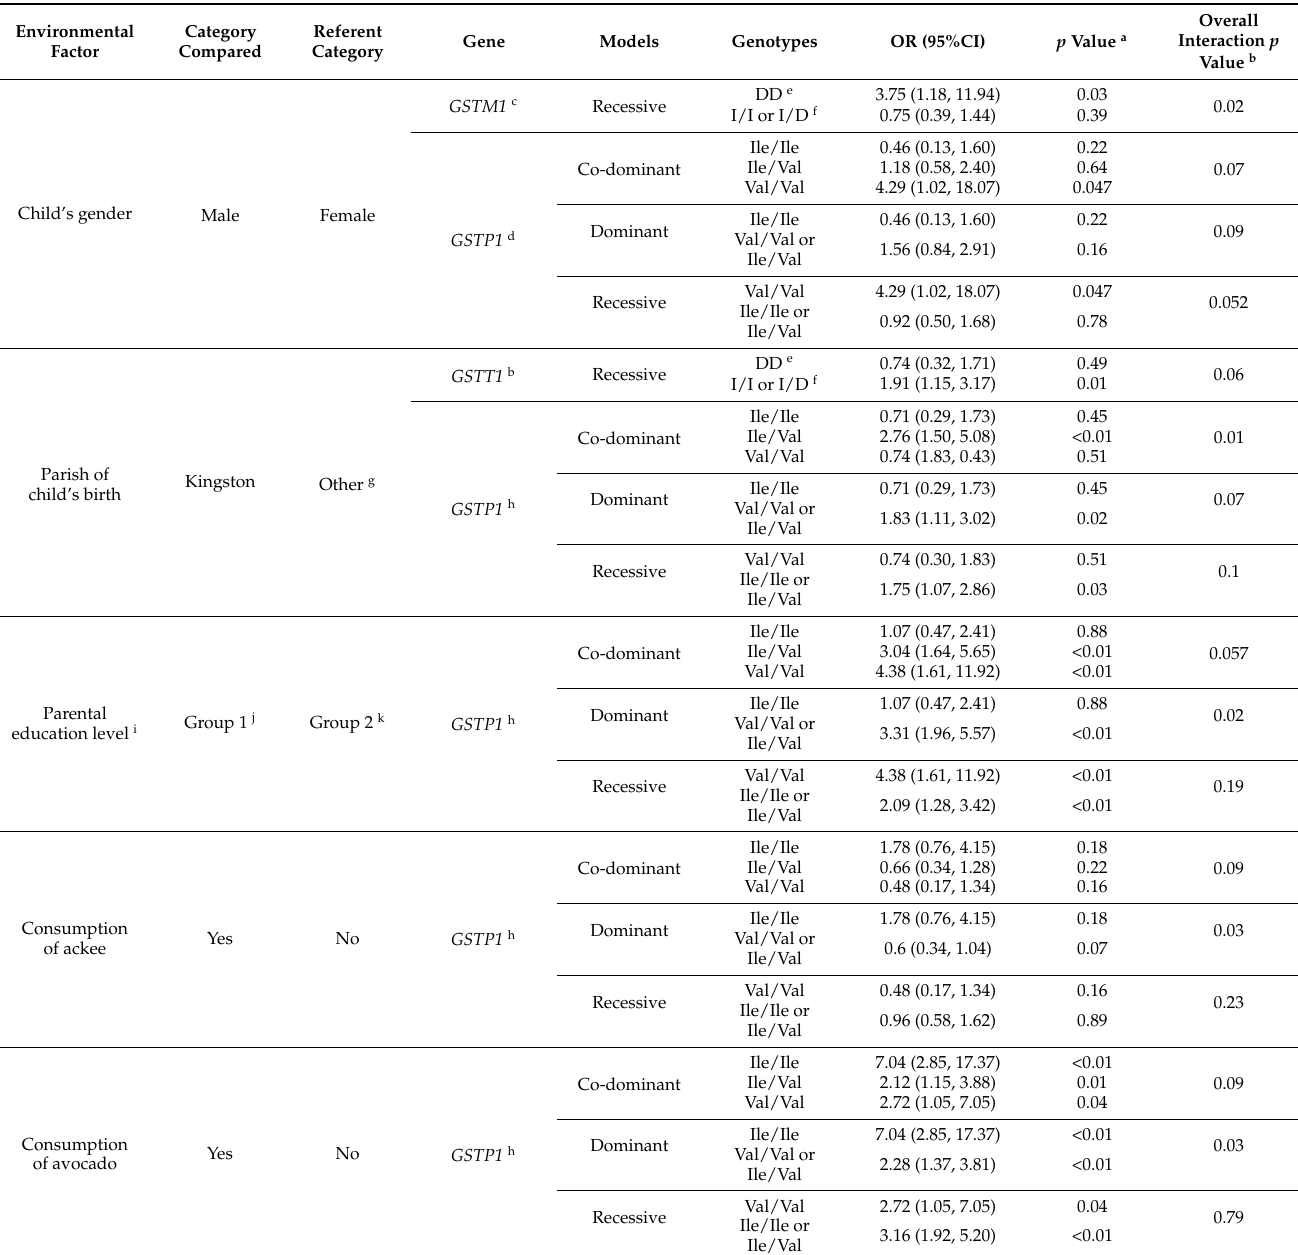
Table 3. Associations between children’s exposure to environmental factors and a binary detectable level of blood As concentrations by children’s genotypes for GST genes based on the multivariable logistic regression models that include the interaction between GST genes and the main environmental exposure ( n =